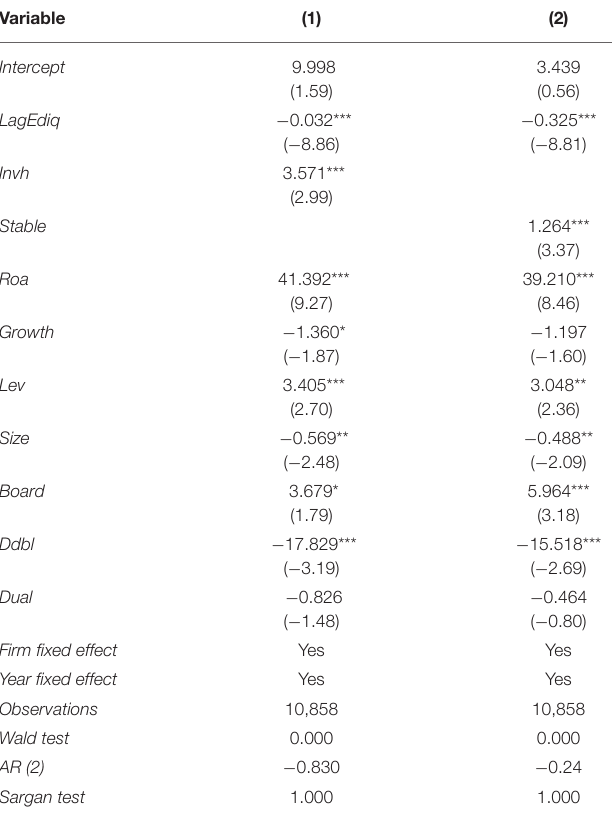
TABLE 9 | Institutional investors’ heterogeneity and environmental information disclosure quality: full